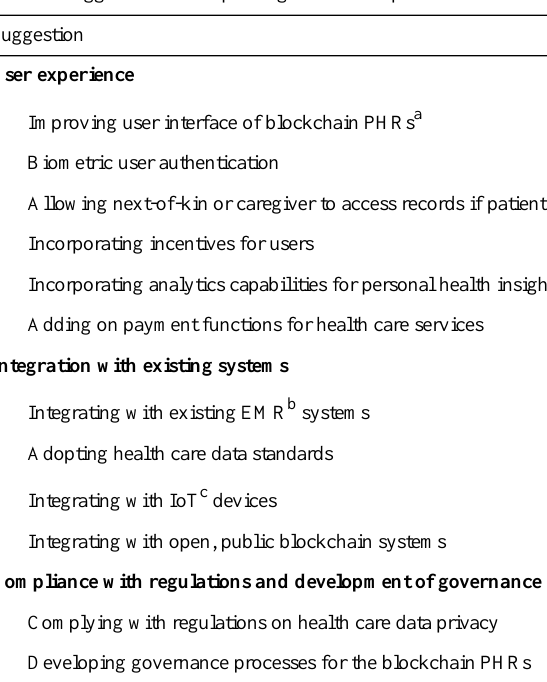
Table 6. Suggestions for improving blockchain personal health record usability from the selected